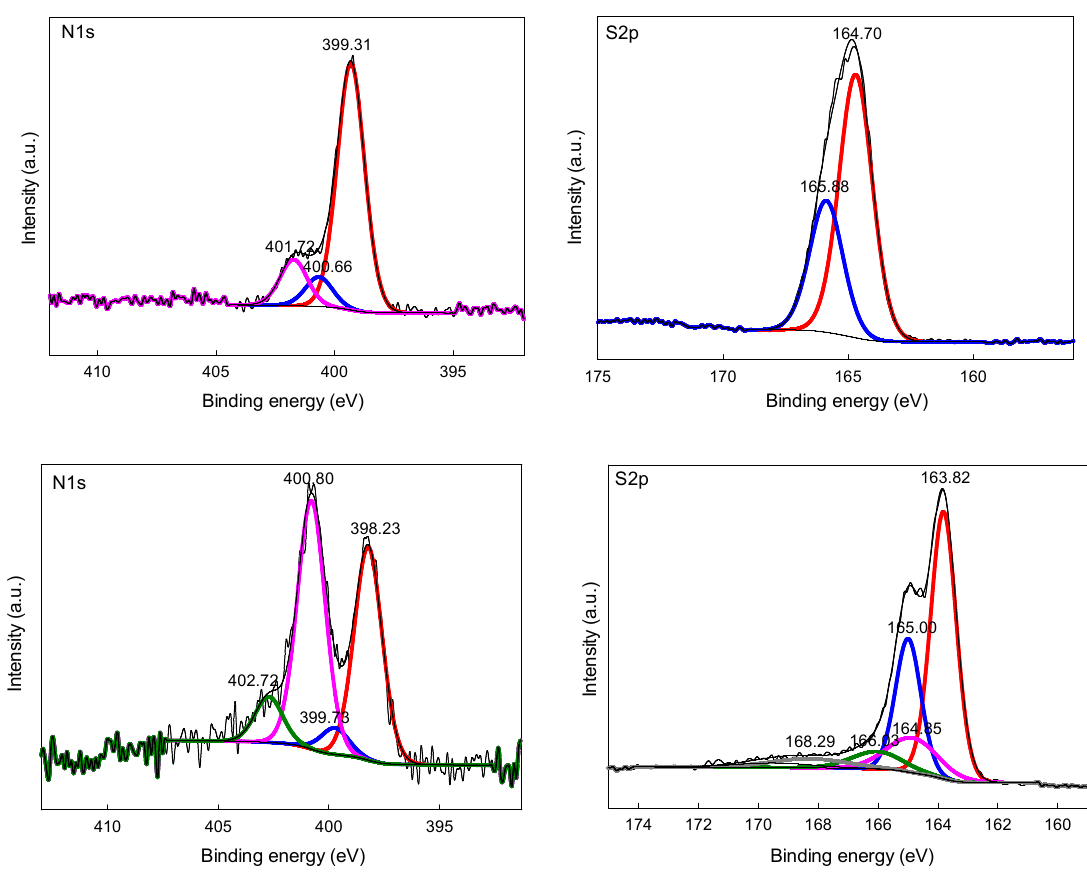
Figure 6. High resolution XPS spectra of N 1s and S 2p of organic (top row) and corresponding carbon (bottom row) gels obtained from 2-thiazolecarboxaldehyde via pyrolysis at 750 ◦